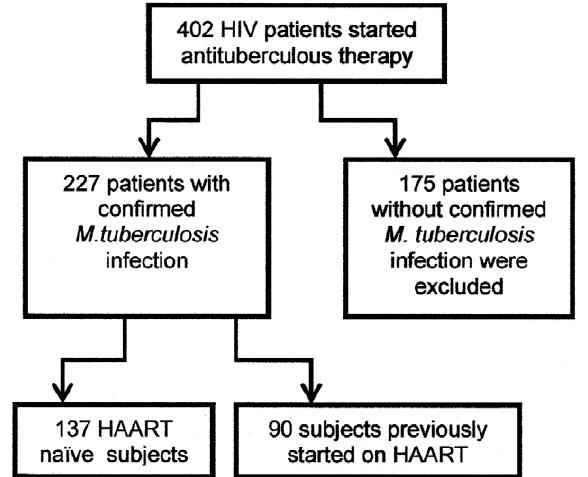
in Table 1. Results of CD4 cell count and HIV viral load preceding the start of antituberculous therapy were available for these measurements and the start of antituberculous therapy